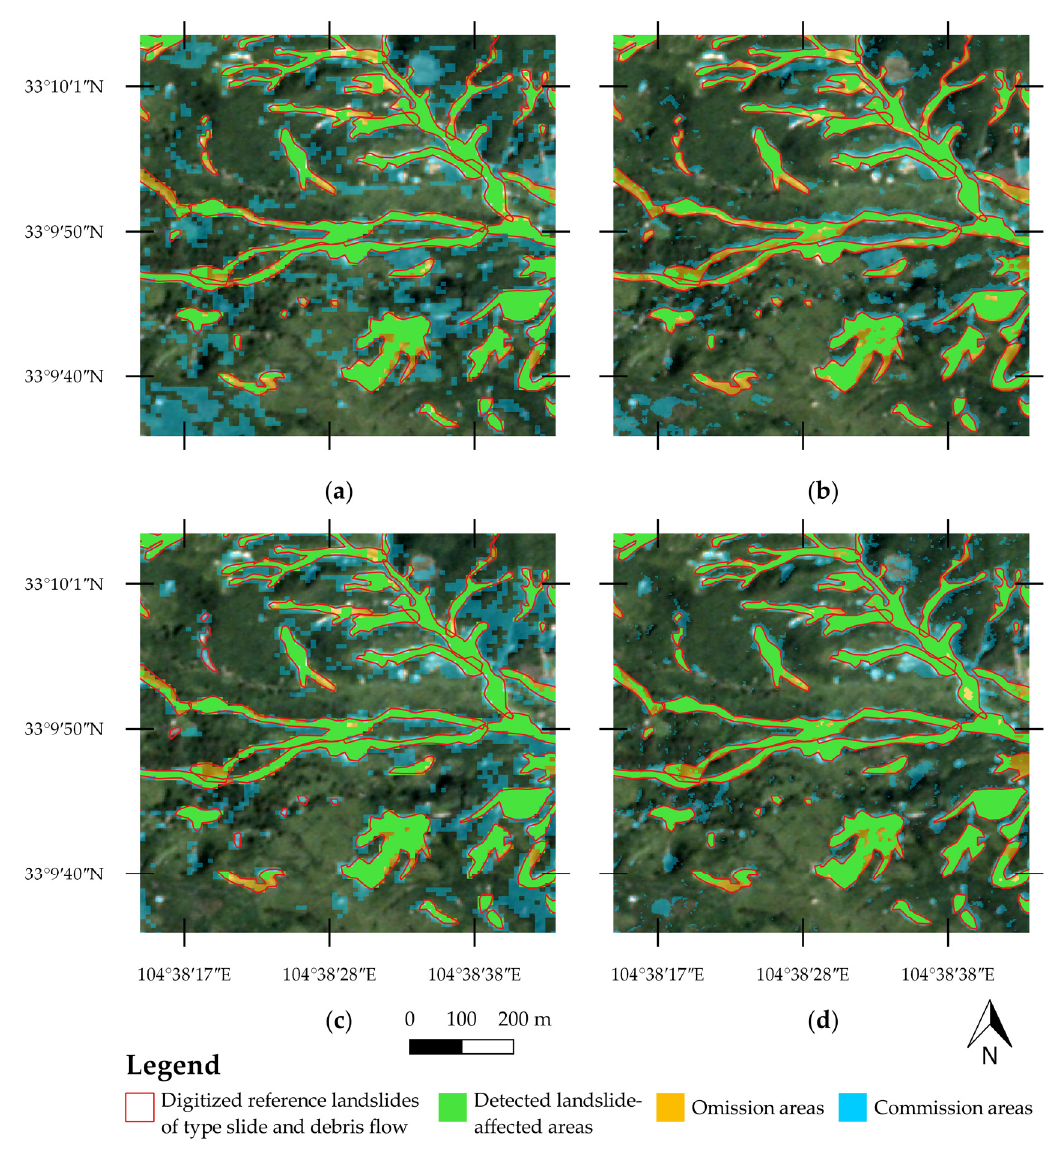
Figure 8. Results of the change detection: ( a ) Expectation–Maximization (EM) with Sentinel-2 imagery, ( b ) EM with PlanetScope imagery, ( c ) Generalized Additive Model (GAM) with Sentinel-2 imagery, and ( d ) GAM with PlanetScope imagery. The manually digitized landslide polygons are displayed in red by their outlines. The results of the change detection are colorized as indicated in the legend. The processing periods are 6 June 2018 and 1 July 2019 for Sentinel-2 and 6 June 2018 and 3 June 2019 for